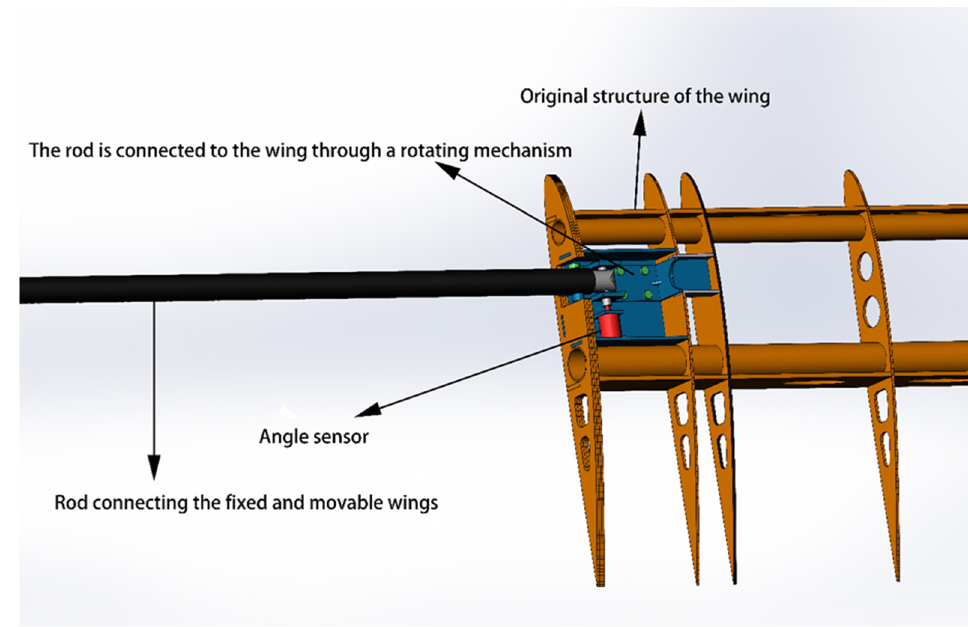
Figure 6. Schematic diagram of the connection mechanism between the wings.